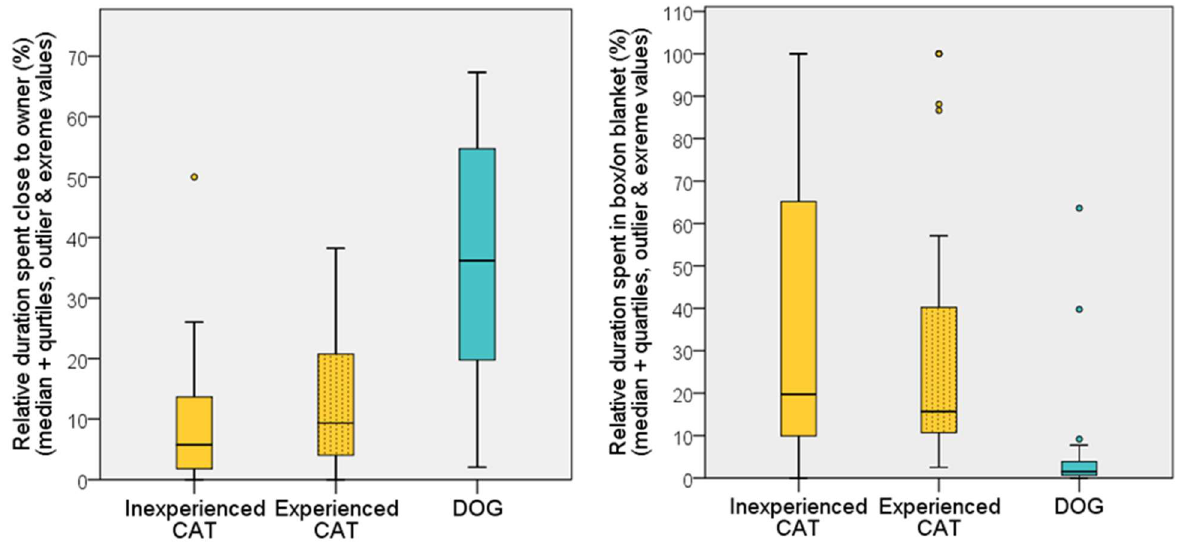
Figure 8. Relative duration (%) of time spent close to the owner and to the box/blanket by dogs and cats during the first 5 min of the habituation test on the first occasion.